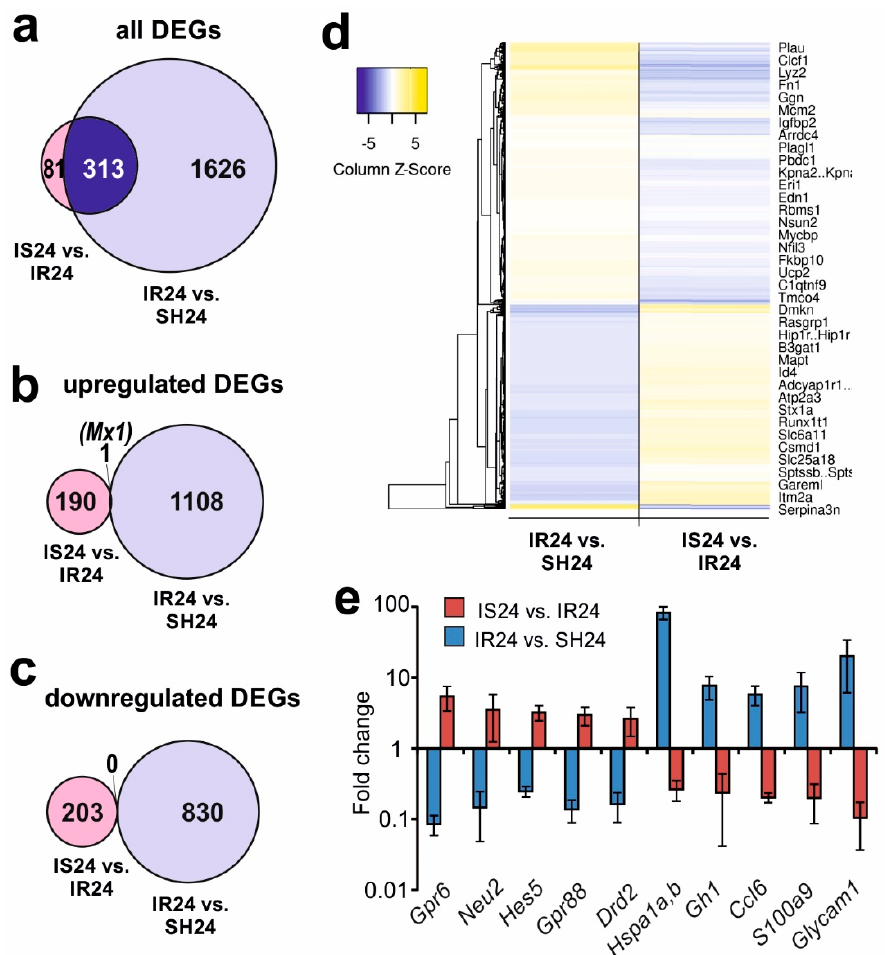
Figure 3. Comparison of the results obtained in two pairwise comparisons of IS24 versus IR24 and IR24 versus SH24. ( a – c ) Venn diagrams of DEGs in two pairwise comparisons of IS24 versus IR24 and IR24 versus SH24. Comparison for all ( a ), up- ( b ) and downregulated ( c ) DEGs. ( d ) Hierarchical cluster analysis of all DEGs in IS24 versus IR24 and IR24 versus SH24. Each column represents a comparison group, and each row represents a DEG. Yellow strips represent high relative expressions and blue strips represent low relative expressions, n = 3 per group. ( e ) The top ten genes that exhibited the greatest fold change in expression in IS24 versus IR24. The data are presented as the mean ± standard error of the mean. The cut-o ff of gene-expression changes was 1.50. Only those genes, whose Padj < 0.05 were selected for